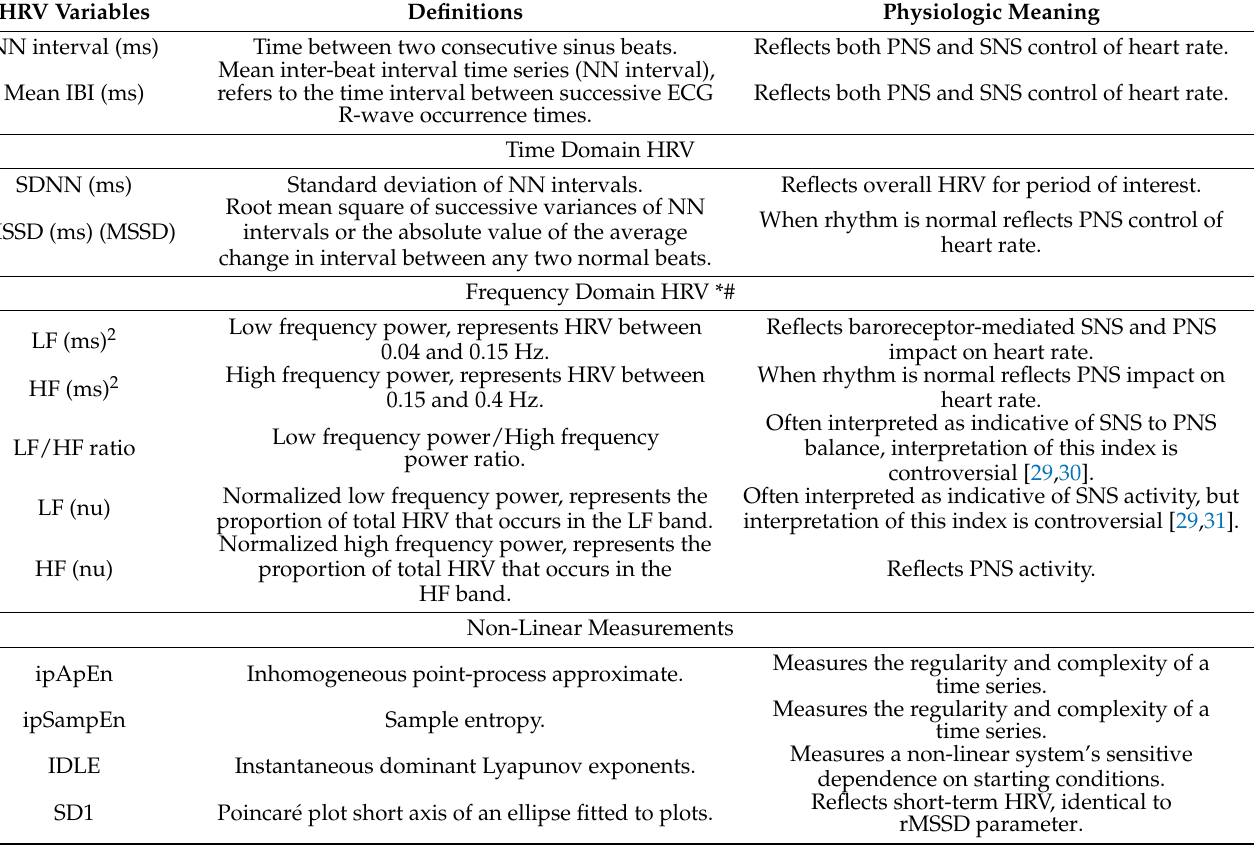
Table 1. Heart rate variability measures used in studies of brain functioning in neuroimaging studies. Based on: